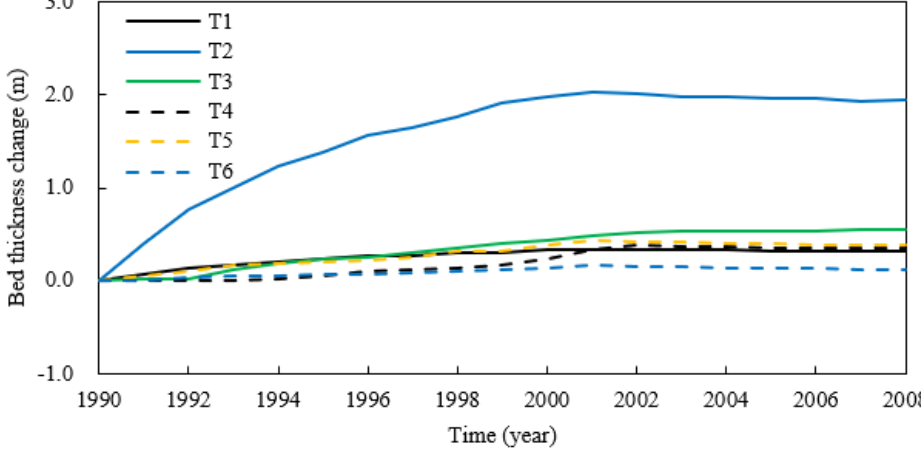
Figure 15. Bed thickness changes at the filed observation stations T1~T6 from 1990 to 2008. The amounts of erosion, deposition and net deposition from 1990 to 2007 are shown in Figure 16. The deposition was much greater than the erosion. The amounts of deposi- tion, erosion and net deposition were123.80 kg/m 2 , 30.34 kg/m 2 , and 93.46 kg/m 2 , respec- tively in 2007, indicating that QL experienced serious deposition during this period, and the average annual net deposition was 5.19 kg/m 2 /y. The change rates tended to rise line- arly with time after 1995 with constant rates of 0.88 kg/m 2 /y (erosion), 4.59 kg/m 2 /y (dep- osition) and 3.71 kg/m 2 /y (net deposition), respectively.